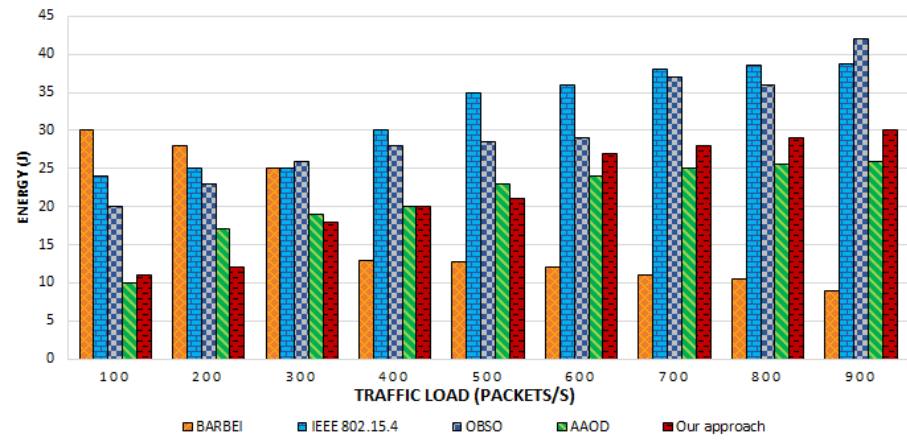
Figure 10. Overhearing and overmitting energy consumption.